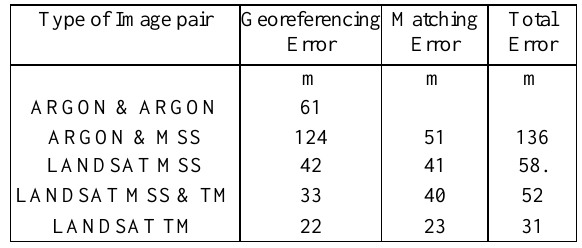
Table 1. The uncertainties of different image types